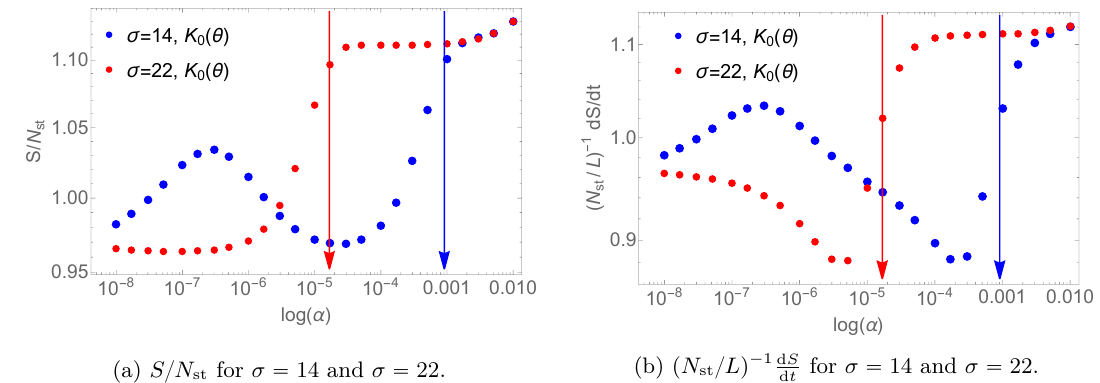
Figure 14 . The total thermodynamic entropy density S { N st (a) with respect to the total particle number density and entropy production rates divided by the particle number density p N d S { d t (b) against α after quenches characterised by K blue dots correspond to σ “ 14 , and the red ones for σ “ 22 . The arrows show the particular α values at which the associated scale variable κ p σ, α q equals